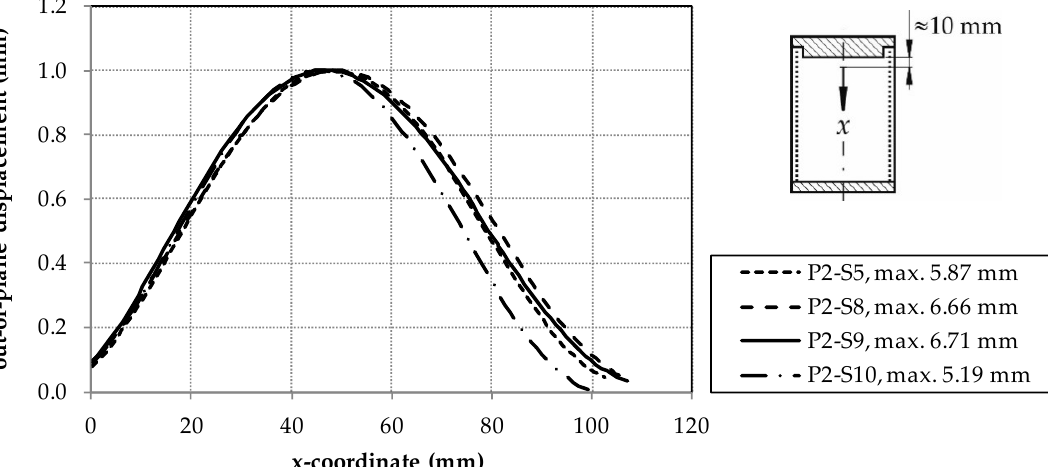
Figure A3. Normalized as well as maximum out-of-plane displacements of specimens investigated with CAI-modified device on the symmetrical line in global x -direction (cp. Figure 2a) starting near top bearing (for P2-S3 no digital imaging correlation data is available).